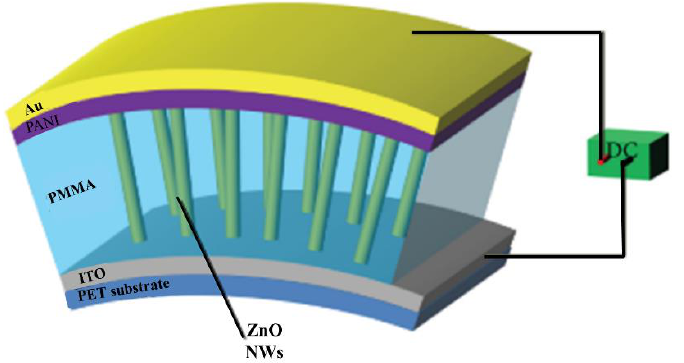
Figure 26. Schematic of the flexible LED device. The simple structure of the device is Au/PANi/ZnO NWs in PMMA matrix/ITO/PET substrate.